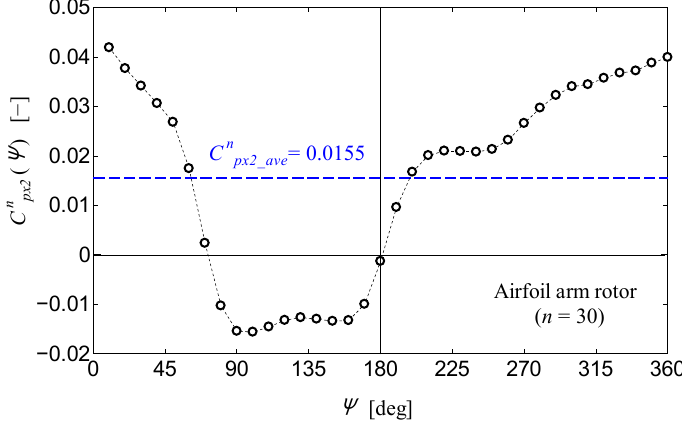
Figure B1. An example showing the azimuth dependency of non-dimensional force coefficient. Figure A2. An example showing the azimuth dependency of non-dimensional force coe ffi